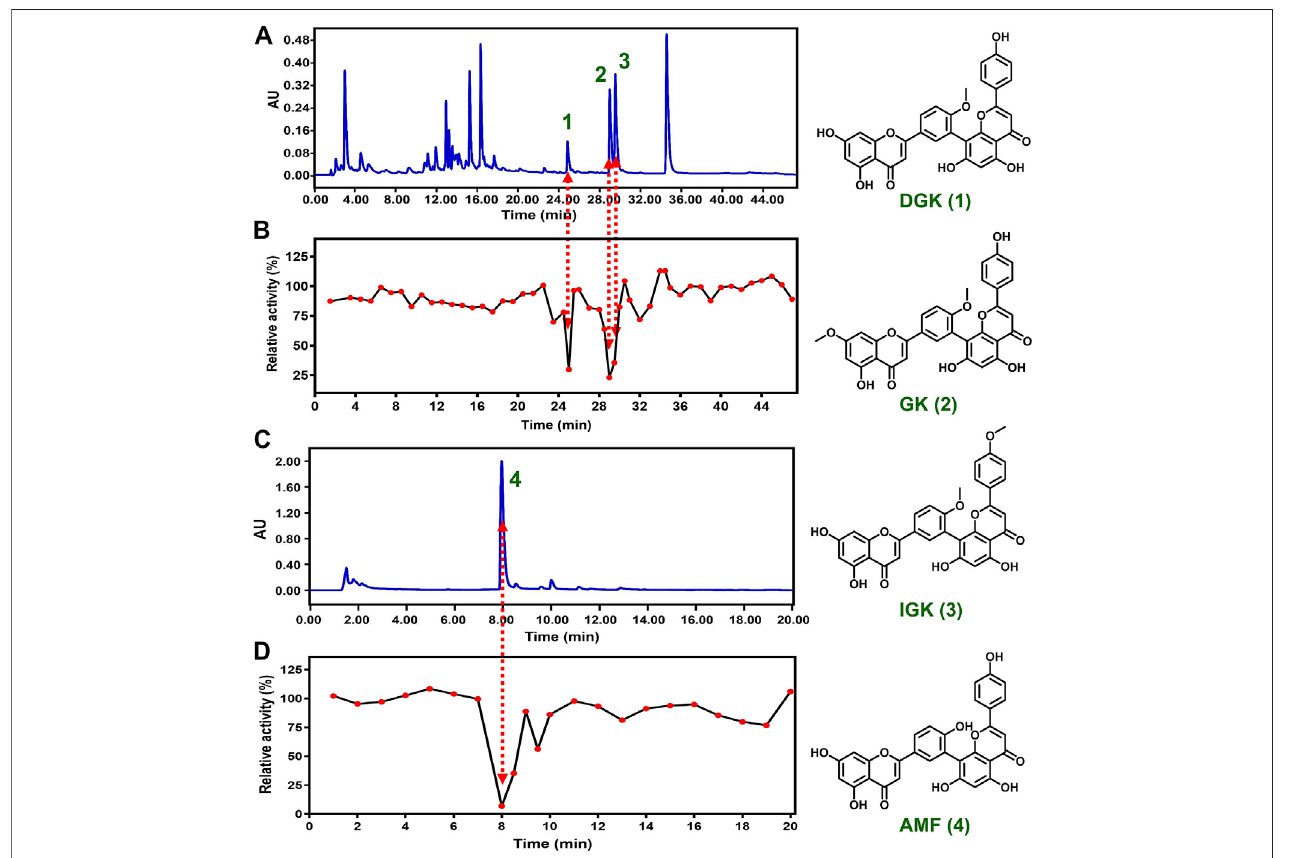
FIGURE 2 | Identi fi cation the inhibitory components toward CYP3A4 in herbal medicines. LC-UV fi ngerprint of GB (A) and ST (C) extract, and the corresponding CYP3A4 inhibition pro fi le of LC fractions (B, D) .